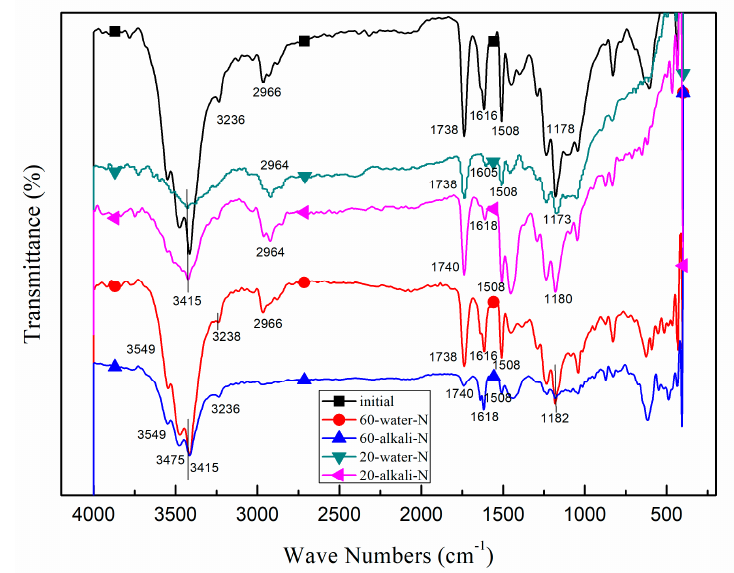
Figure 17. FTIR of the initial CFRP plate and that immersed for 135 days (numbers in the figure shows the specific value of the spectrum of absorption).